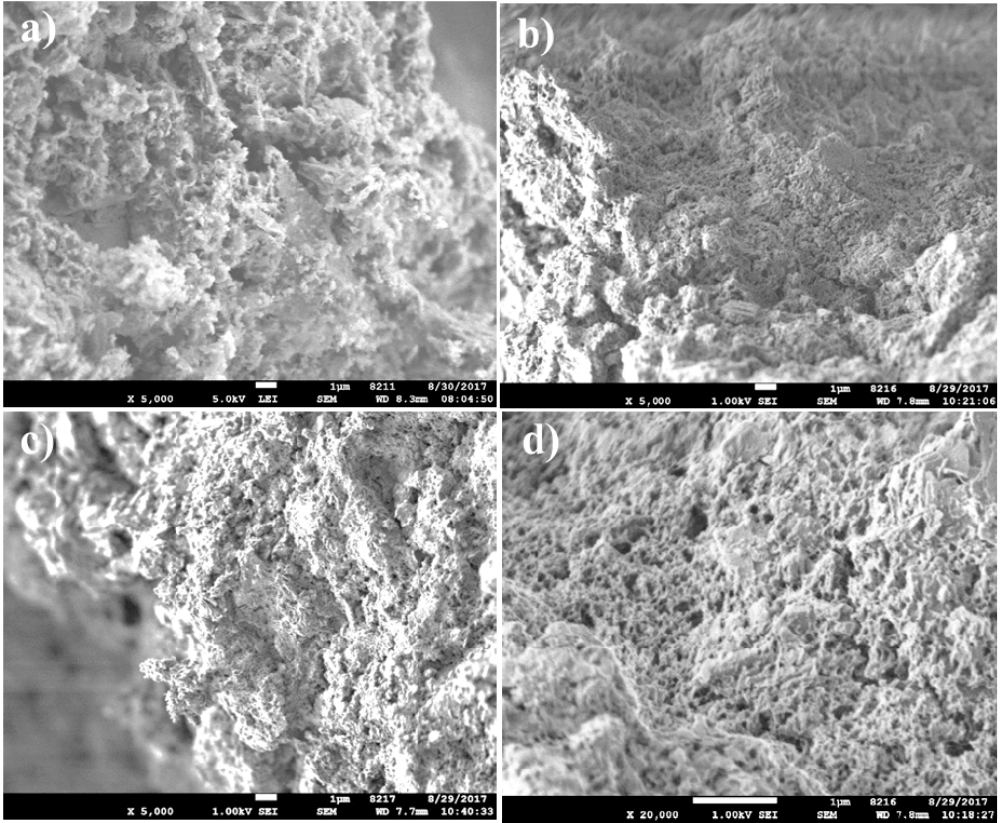
Figure 10. SEM pictures of prepared and modified foams: S ( a ), 0.1 M + 3 M ( b ), 600 ( c )—magnification 5000 × , and 0.1 M + 3 M ( d )—magnification 20,000 ×